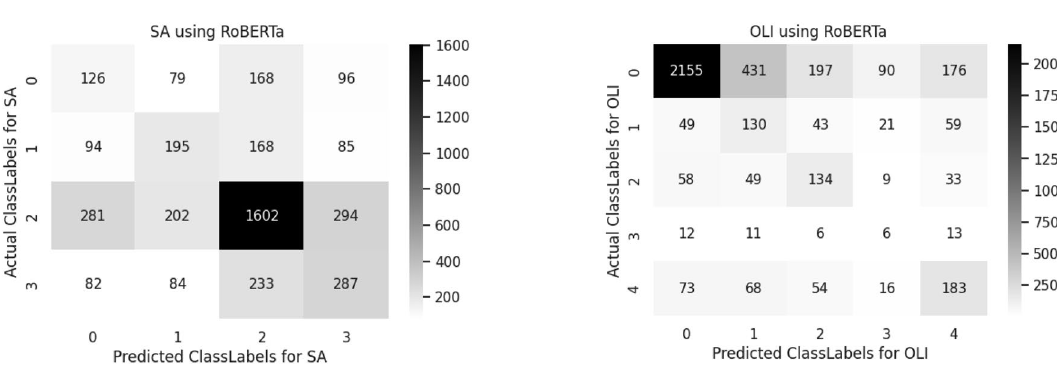
Figure 7. Confusion matrix of RoBERTa for sentiment analysis and offensive language identification.